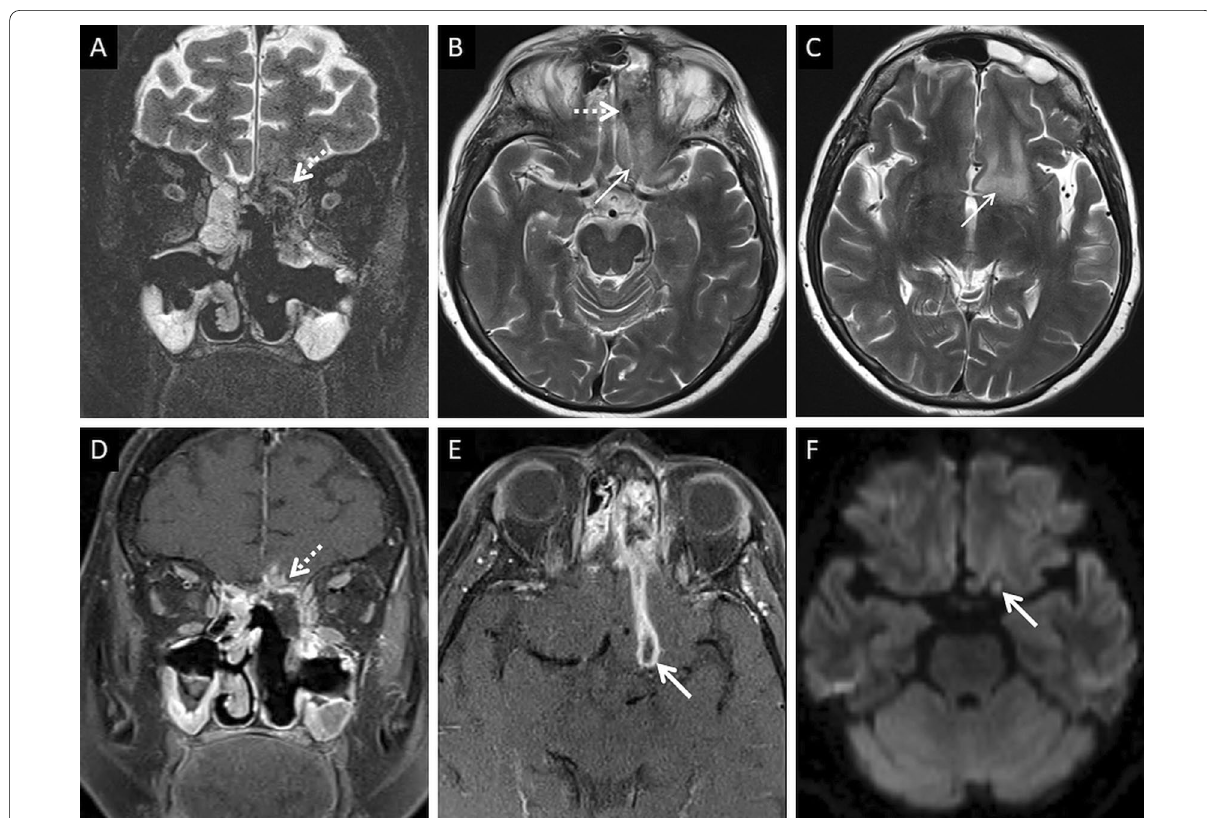
Fig. 15 Cerebritis and parenchymal abscess formation in ROCM. Pre-operative imaging workup was performed at another institution. Post-operative MRI, performed at our institution, is presented. Coronal T2-FS image ( a ) demonstrates ill defined, hypointense soft tissue in the left ethmoid air cells, invading into the left anterior cranial / left olfactory fossa (dotted arrow). Axial T2W images of the brain ( b , c ) demonstrates the hypointense soft tissue (dotted arrow in B) along with vasogenic oedema in the left basifrotnal white matter (thin arrows in b , c ). CE FS coronal T1W image ( d ) shows abnormal parenchymal enhancement (dotted arrow) of the left gyrus rectus suggesting cerebritis, due to fungal invasion. CE FS axial T1W image ( e ) shows a peripherally enhancing lesion (thick arrow) along the posterior portion of the left gyrus rectus. Axial diffusion weighted image ( f ) shows restricted diffusion within the peripherally enhancing lesion (thick arrow), suggesting abscess